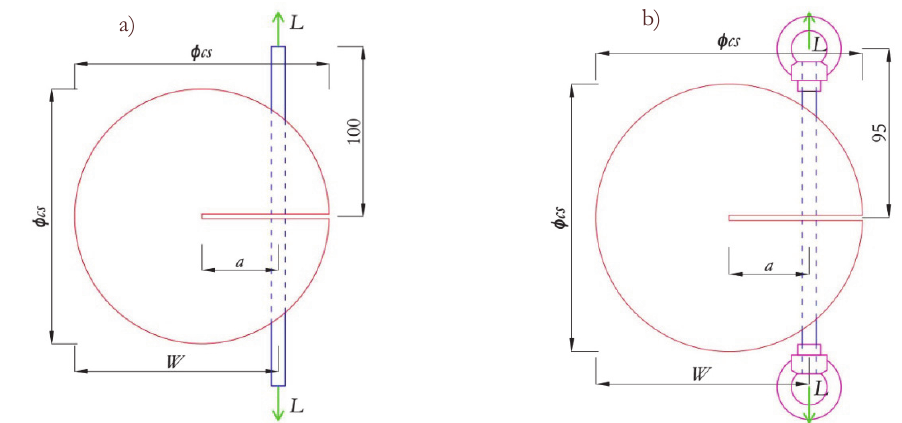
Figure 2: Schematic diagram of a modified compact tension test with dimensions in 2D: a) current set-up; b) set-up with eye nuts at the ends of the steel bars.